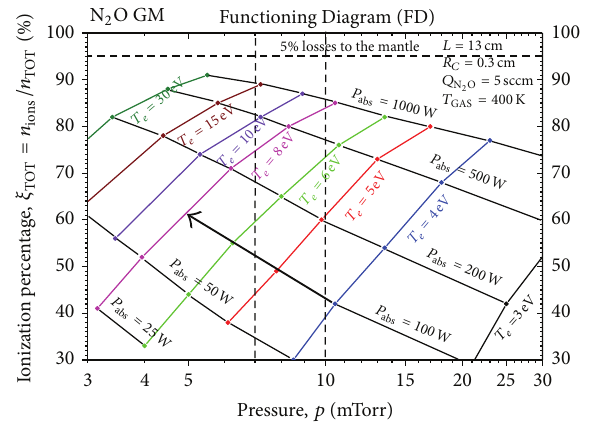
Figure 15: “Functioning Diagram” (FD) for the feeding of 5 sccm and for the “core” region of the Ar fed HPT.